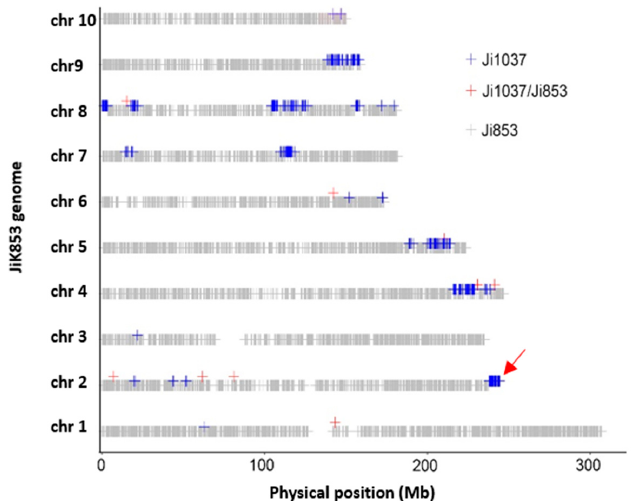
Figure 3. Characterization of both donor (Ji1037) and recurrent (Ji853) parental genome contributions to JiK853, which was essentially derived varieties of Ji853 through backcross breeding. The red arrow indicates the genome position of the head smut resistance introgression from